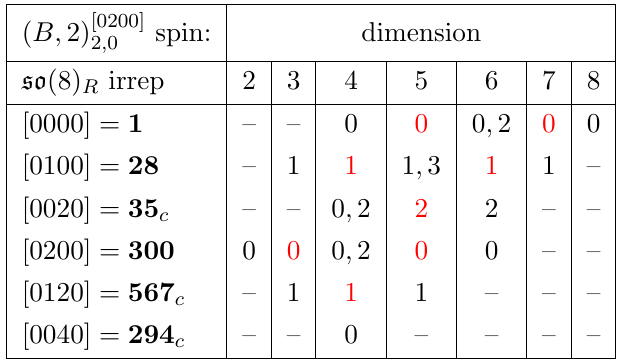
Table 22 . All possible conformal primaries in S 2 (cid:2) S 2 and S 3 (cid:2) S 3 corresponding to the ( B; 2) [0200] superconformal multiplet.